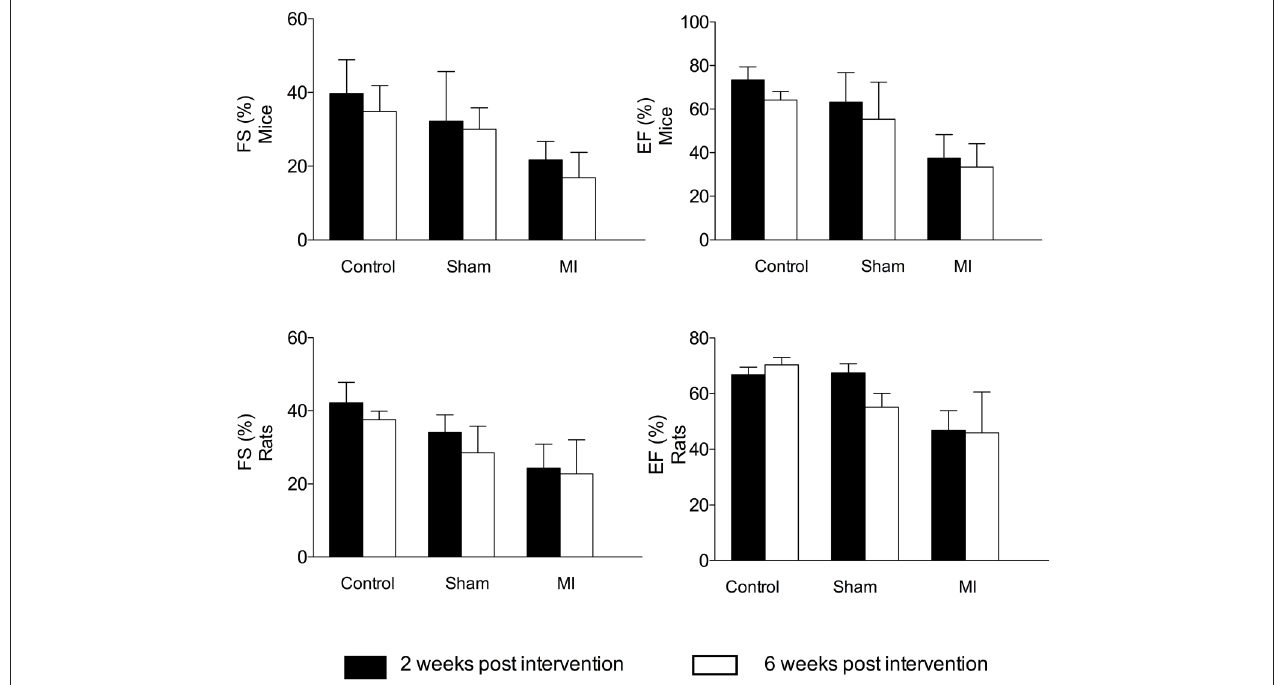
FIGURE 1 | Longitudinal echocardiographic assessments of heart function performed at 2 weeks (black bars) and 6 weeks (white bars) after the time of surgery are represented for mice (above) and rats (below). The fractional shortening (FS) was calculated using the M-mode and ejection fraction (EF) from the two-dimensional imaging mode. The animals were healthy (control group, n = 3 mice and rats), sham-operated ( n = 3 mice and rats), or received a LAD ligation ( n = 8 mice and n = 15 rats).